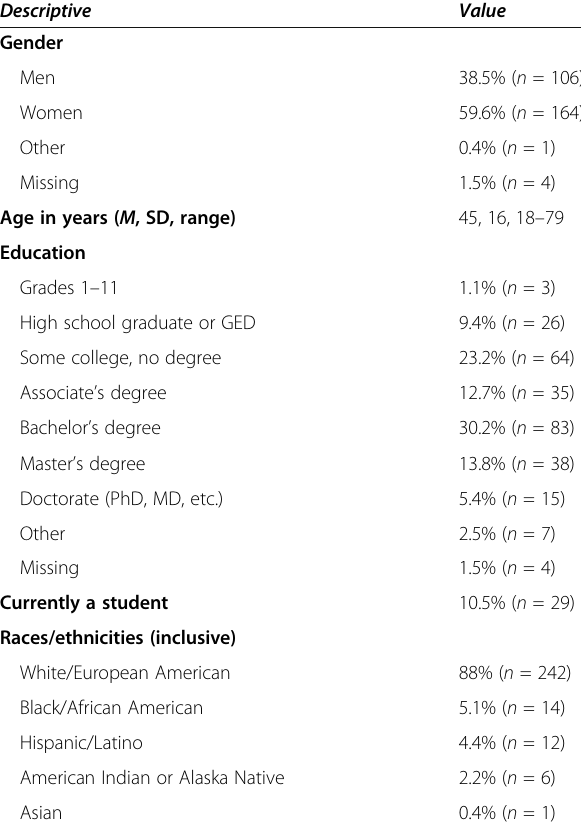
Table 1 Sociodemographic characteristics of 275